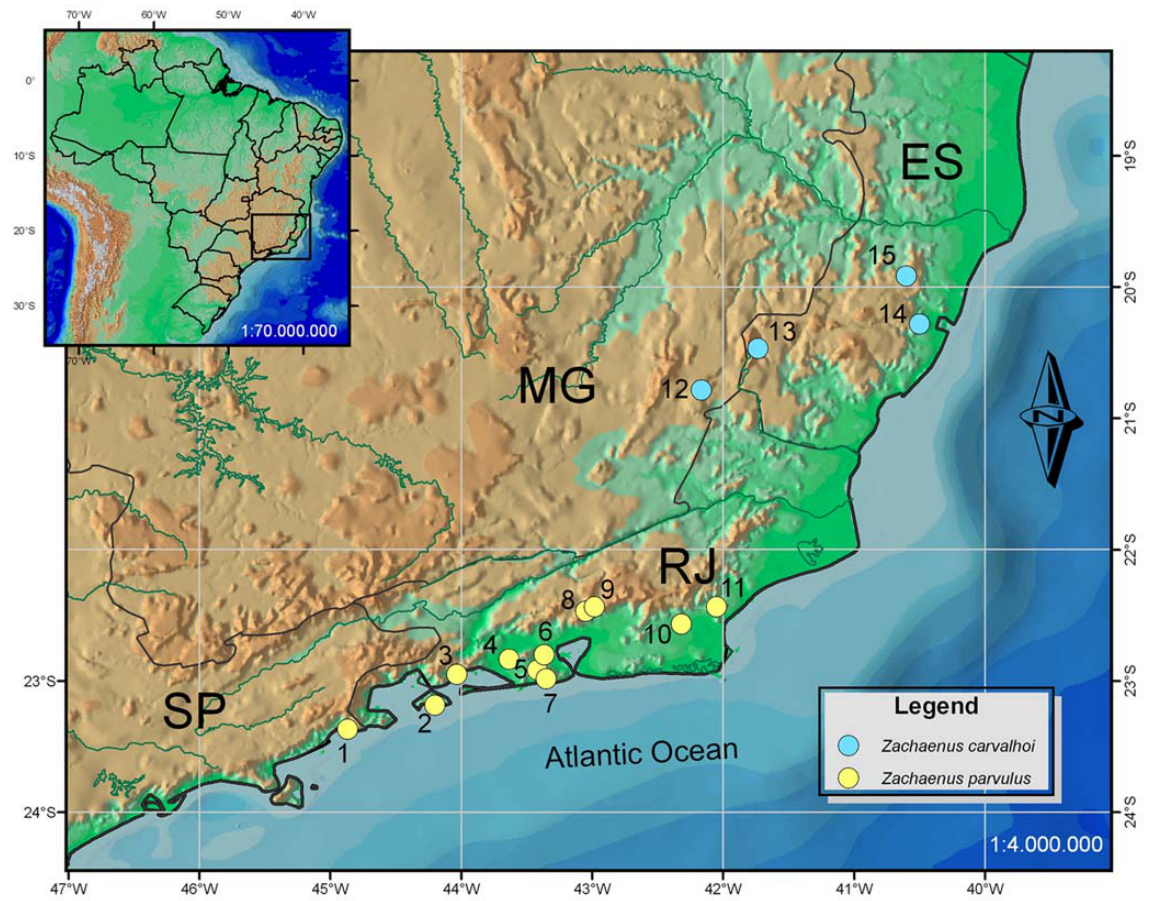
Figure 3. Distribution of Zachaenus carvalhoi and Z . parvulus . Localities: 1. Picinguaba, municipality